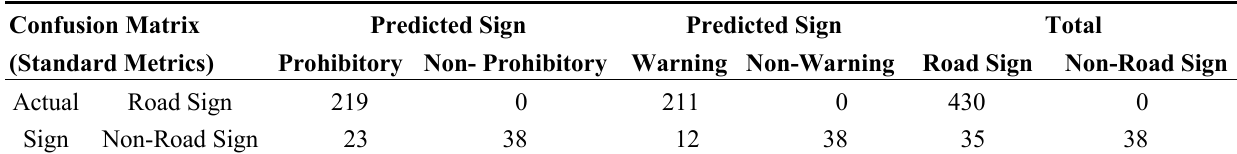
Table 5. The experimental results of standard metrics for static images.